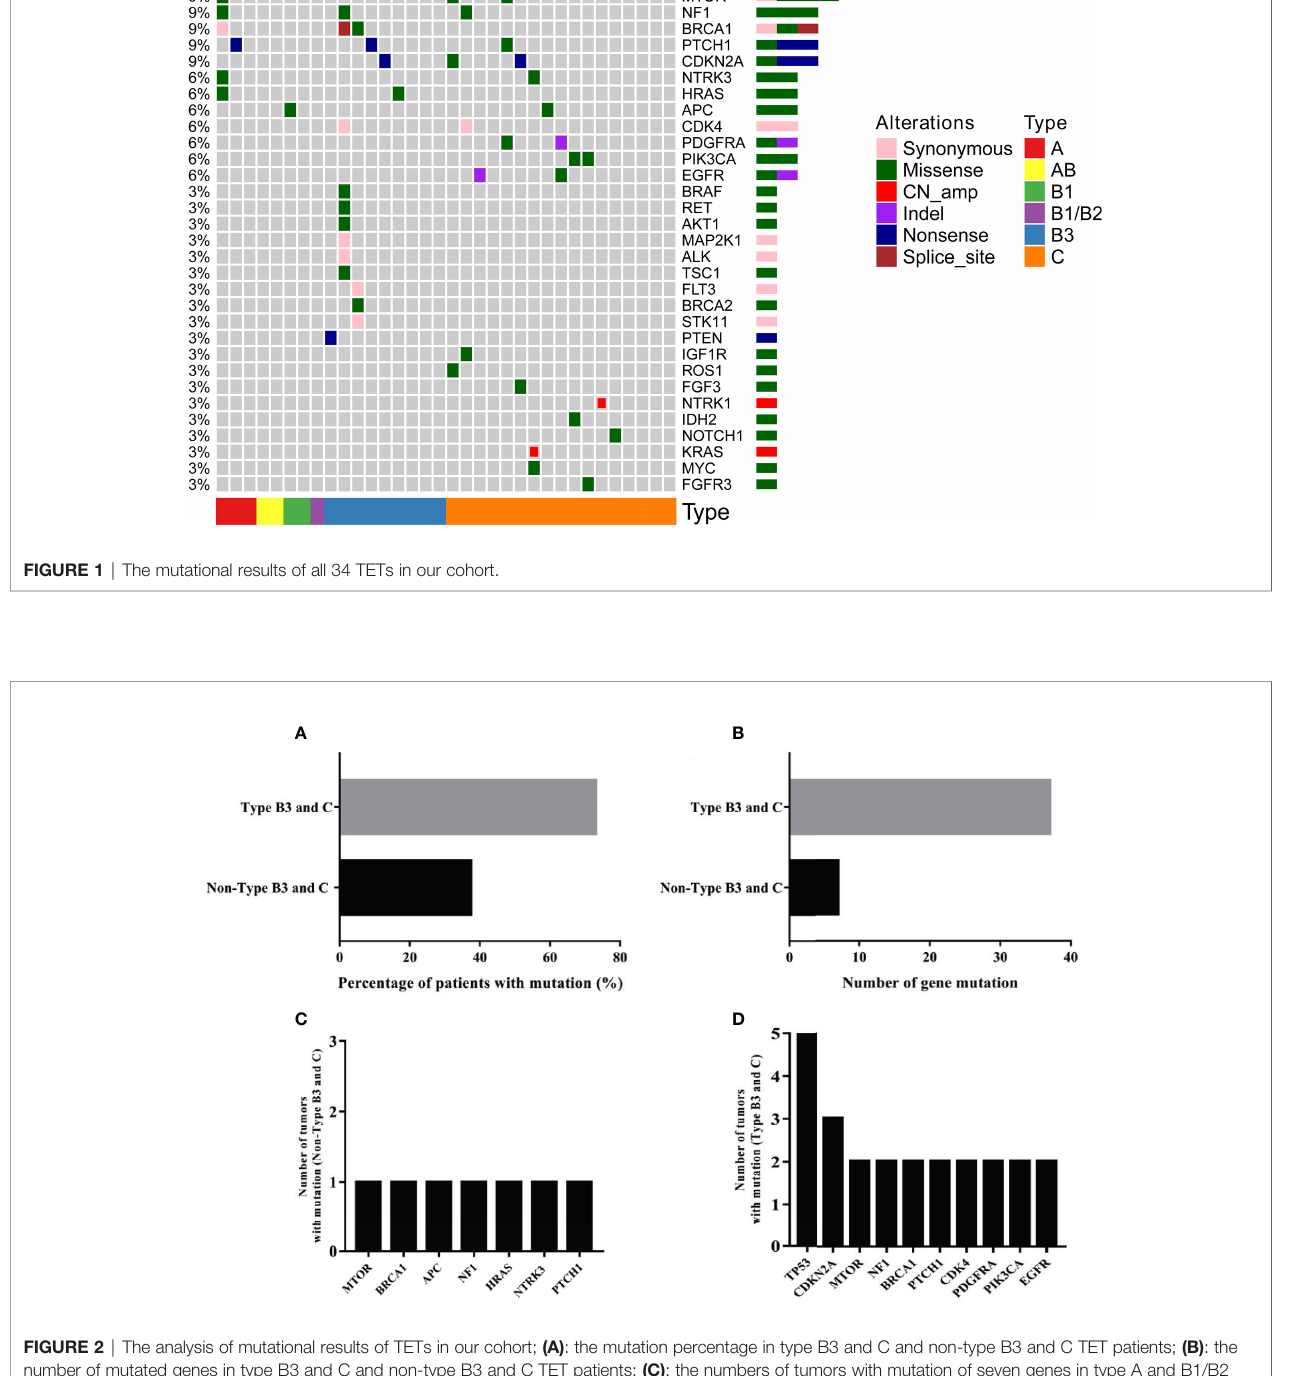
FIGURE 2 | The analysis of mutational results of TETs in our cohort; (A) : the mutation percentage in type B3 and C and non-type B3 and C TET patients; (B) : the number of mutated genes in type B3 and C and non-type B3 and C TET patients; (C) : the numbers of tumors with mutation of seven genes in type A and B1/B2 thymomas; (D) : ten most frequently mutational genes in type B3/C TETs patients.